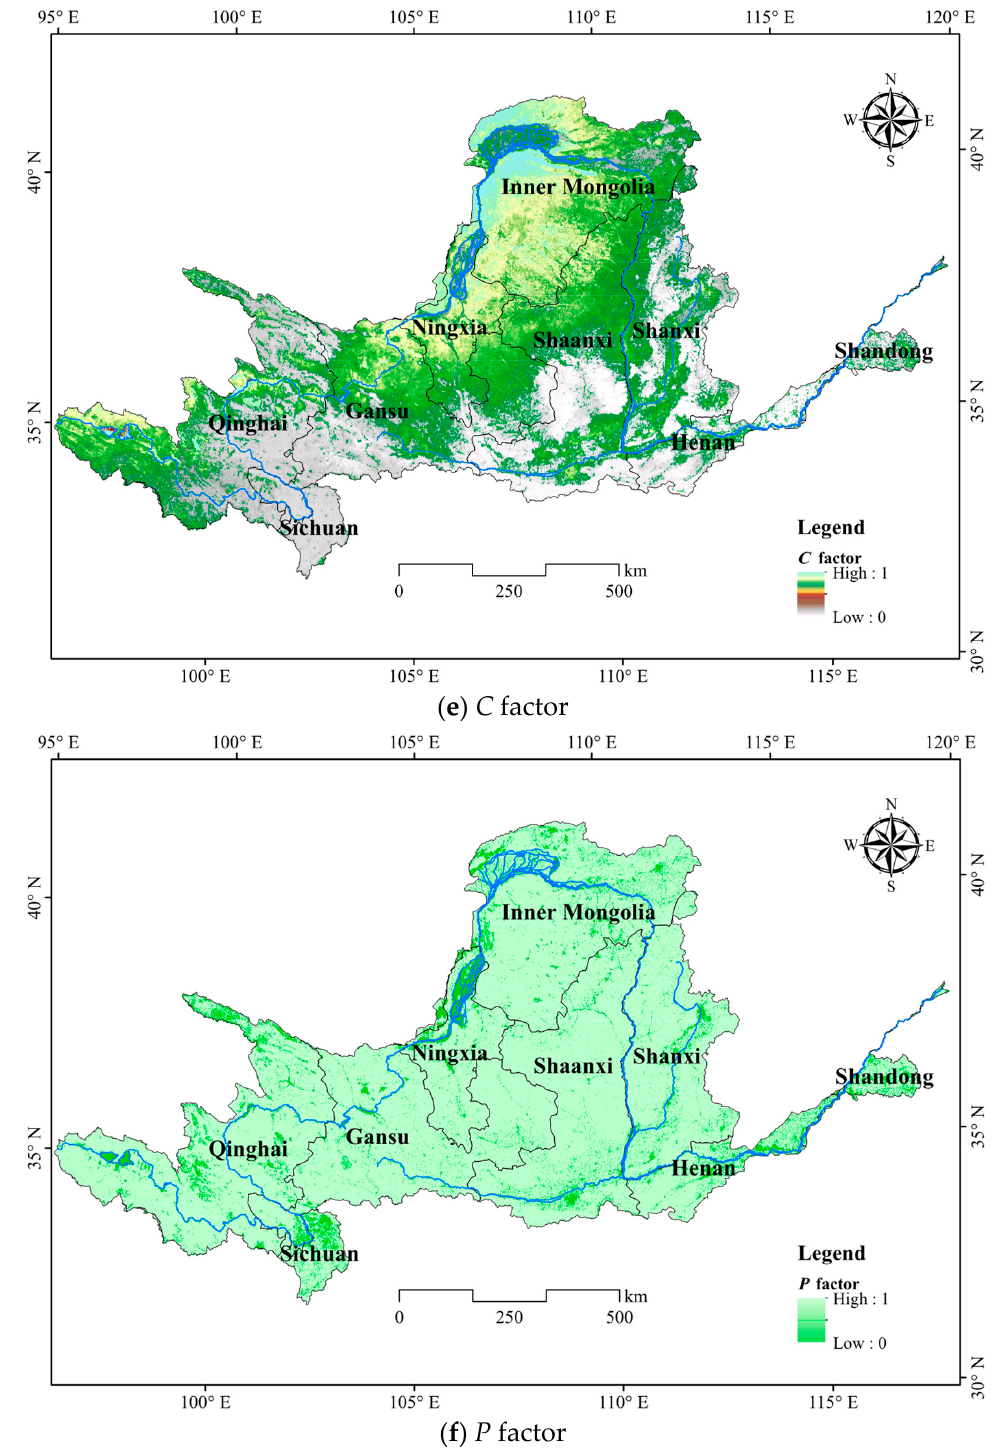
Figure 3. Factors of the RUSLE model. ( a , b ) present the R factor under N45 and N85 scenarios; ( c – f ) K , LS , C and P factors in RUSLE model, respectively.